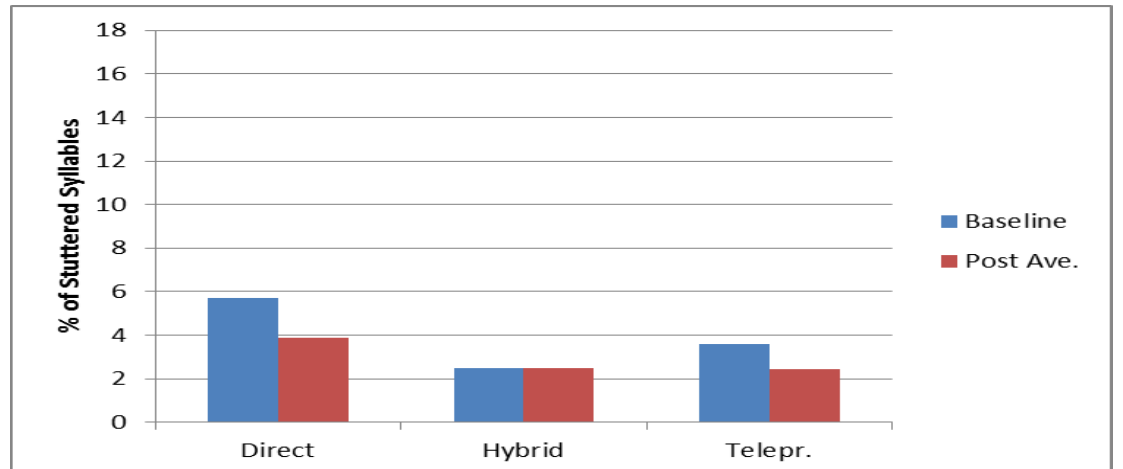
Figure 4. Participant 2: percentage of stuttered syllables in a speaking task (Post Ave= Post Average; Telepr=